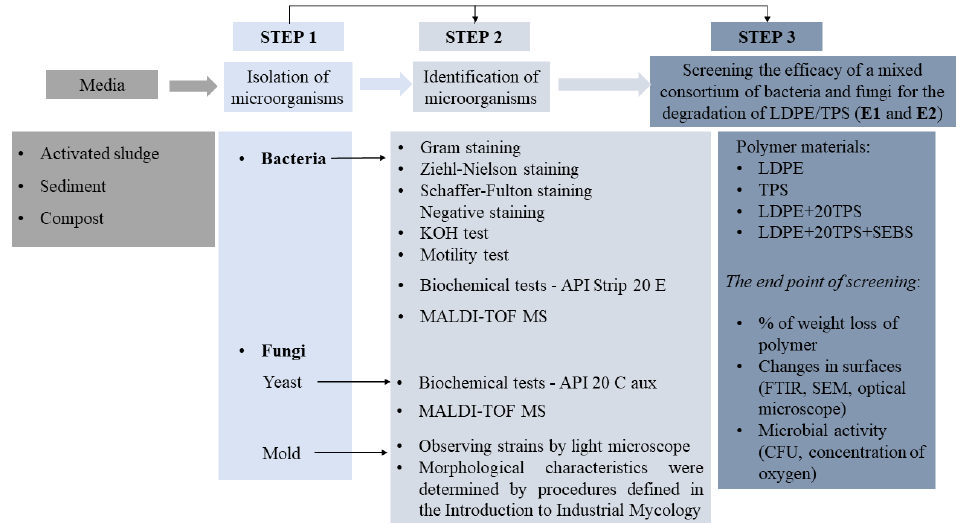
Figure 1. Procedures for isolation, identification, and